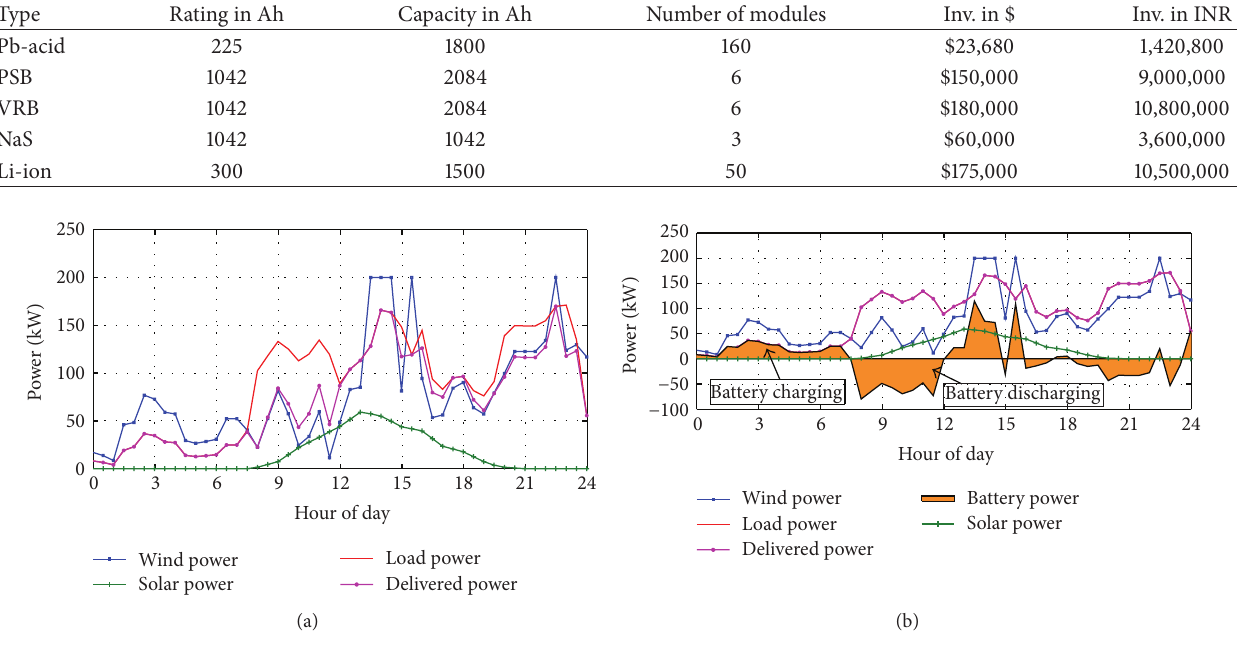
Figure 9: (a) Hybrid system output without battery storage. (b) Hybrid system output with battery storage.